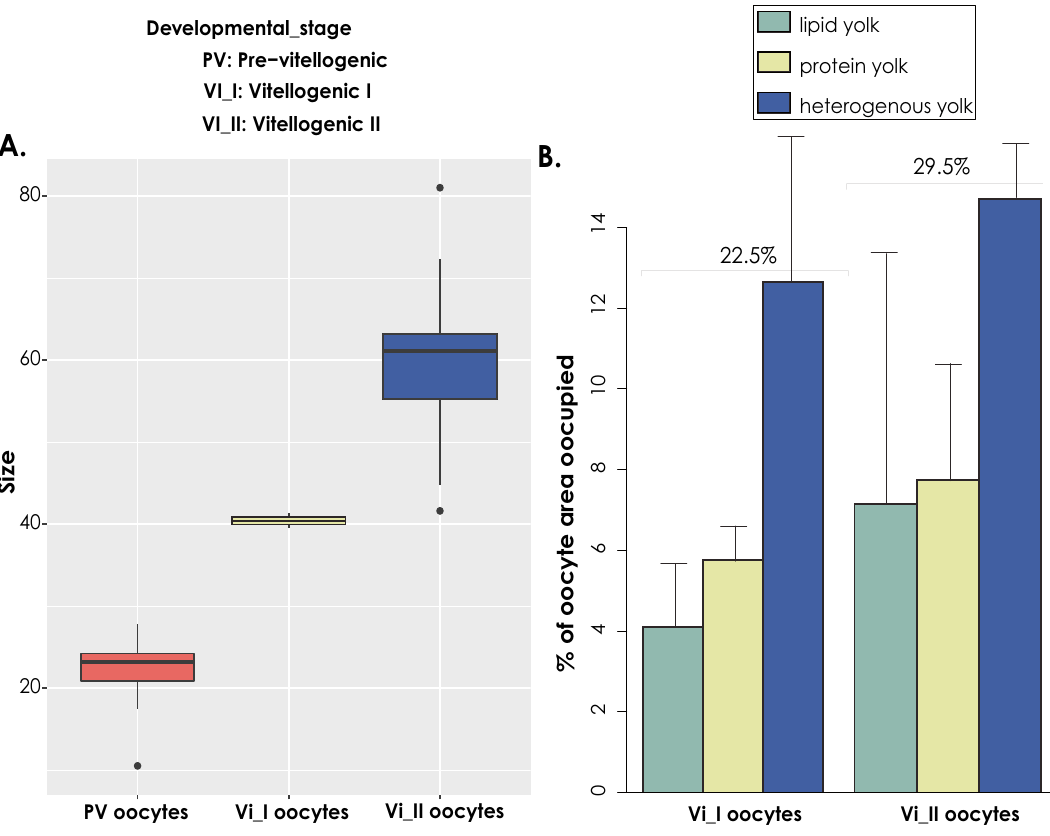
Figure 2. Measurements of oocyte size and yolk content. ( A ) Average size (μm) of previtellogenic (PV), vitellogenic_stage I (Vi_I) and vitellogenic_stage II (Vi_II) oocytes. ( B ) Percentage of the oocyte area occupied by the different types of yolk. For these measurements one specimen with vitellogenic stage I oocytes and another specimen with vitellogenic stage II oocytes were